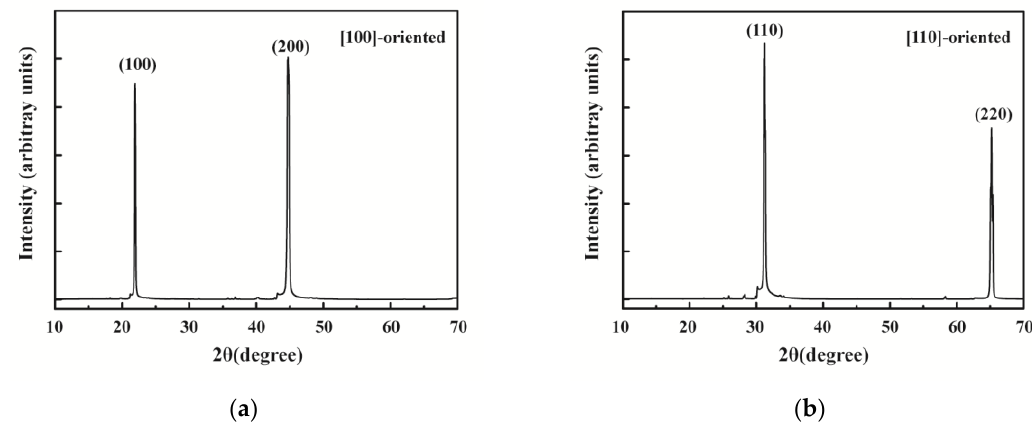
Figure 1. XRD patterns from the main planes of ( a ) [100]- and ( b ) [110]-oriented Pb(In 1/2 Nb 1/2 )O 3 –Pb(Mg 1/3 Nb 2/3 )O 3 –PbTiO 3 (PIN–PMN–PT) single crystals.